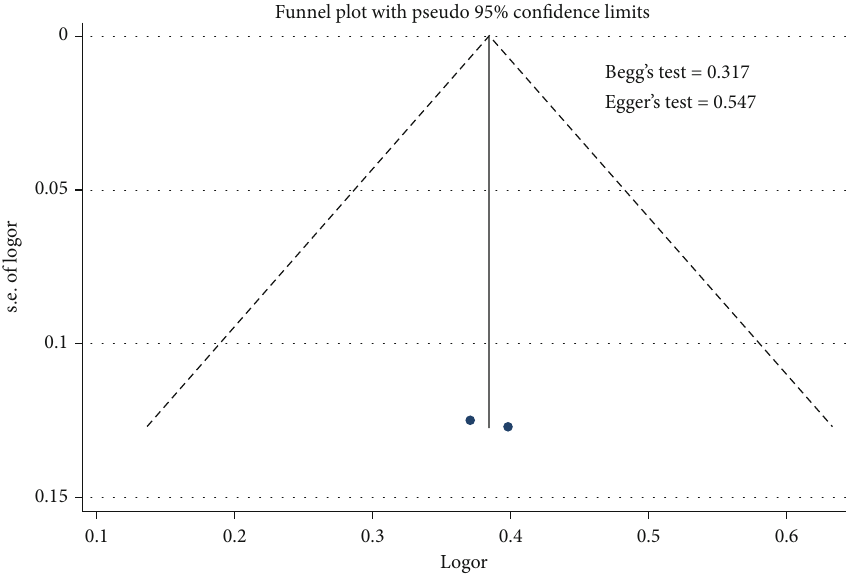
Figure 13: Funnel plots role of triglycerides on the uncontrolled